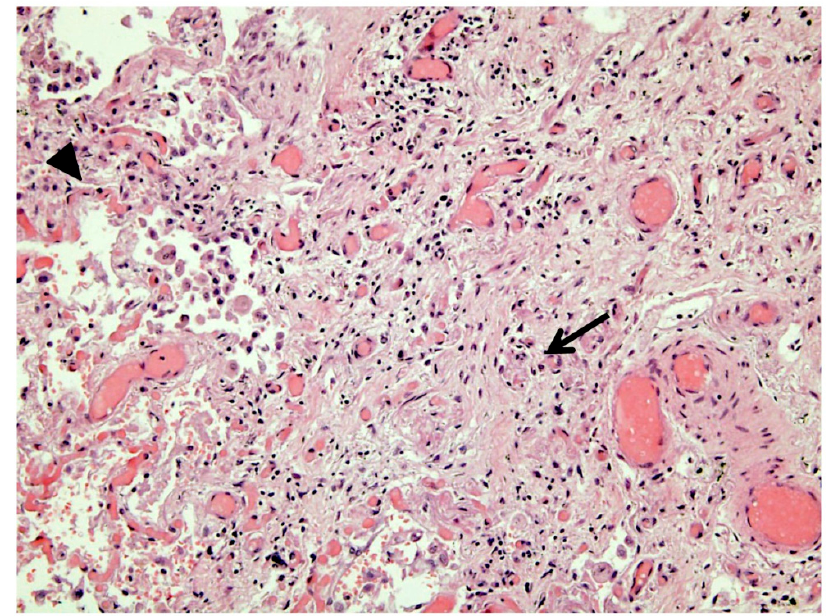
Figure 3. Necropsy. Pulmonary tissue. Nonspecific interstitial pneumonia consistent with evolved interstitial fibrosis (arrow) combined with areas of diffuse alveolar damage (arrowhead). Hematoxylin and eosin staining.